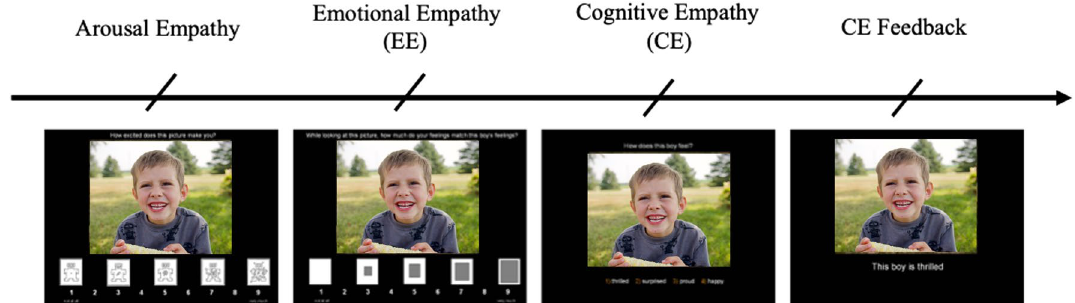
Figure 3. Example trial for ‘thrilled’ emotion depicted on MET-J task. The surveys read 1) “How excited does this picture make you” (implicit emotional empathy/arousal empathy), 2) “While looking at the picture, how much do your feelings match the boy’s feelings (emotional empathy; EE, and 3) “How does this boy feel?” (cognitive empathy; CE). Cognitive empathy emotion label options are 1) thrilled, 2) surprised, 3) proud, 4) happy. The slides for this trial example were designed on PowerPoint using a free-use stock image from the Canva.com image Measures. The Social Responsiveness Scale–Second Edition 64 (SRS-2) was used to measure autistic traits dimensionally across the full sample. Adult participants in both diagnostic groups completed the SRS-2 adult self-report form, whereas parents or guardians of children/adolescents in both groups completed the analogous caregiver-report questionnaire, the SRS-2 School Age form. To facilitate comparison across the different groups, the SRS-2 total scores were converted to T- scores ( M = 50, SD = 10). Empathy.